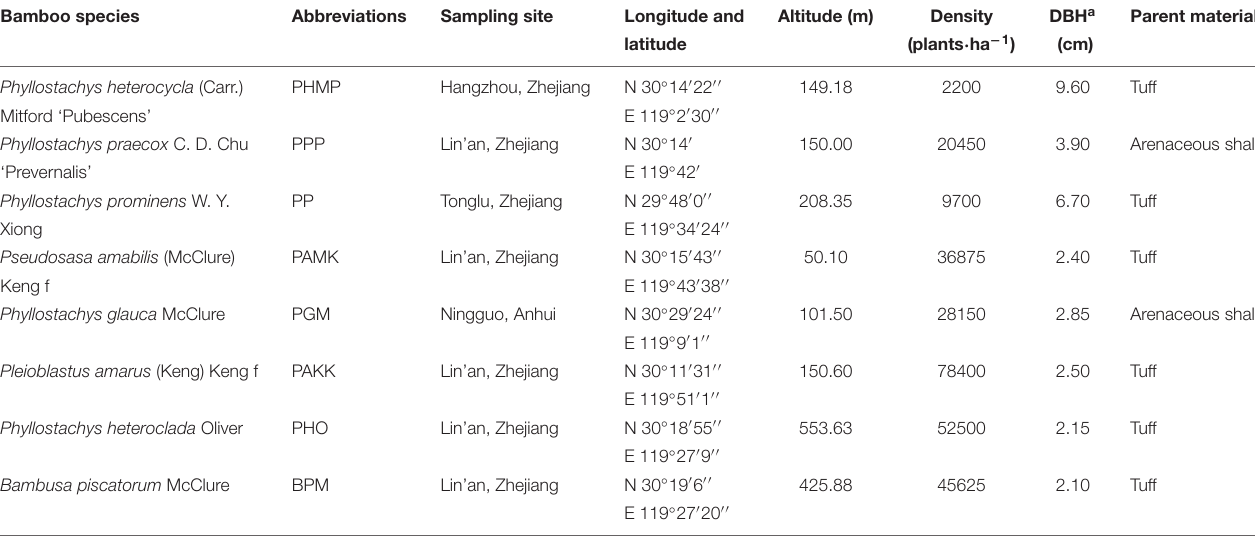
TABLE 1 | Site information of sampling plots of eight monopodial bamboo species studied. Bamboo